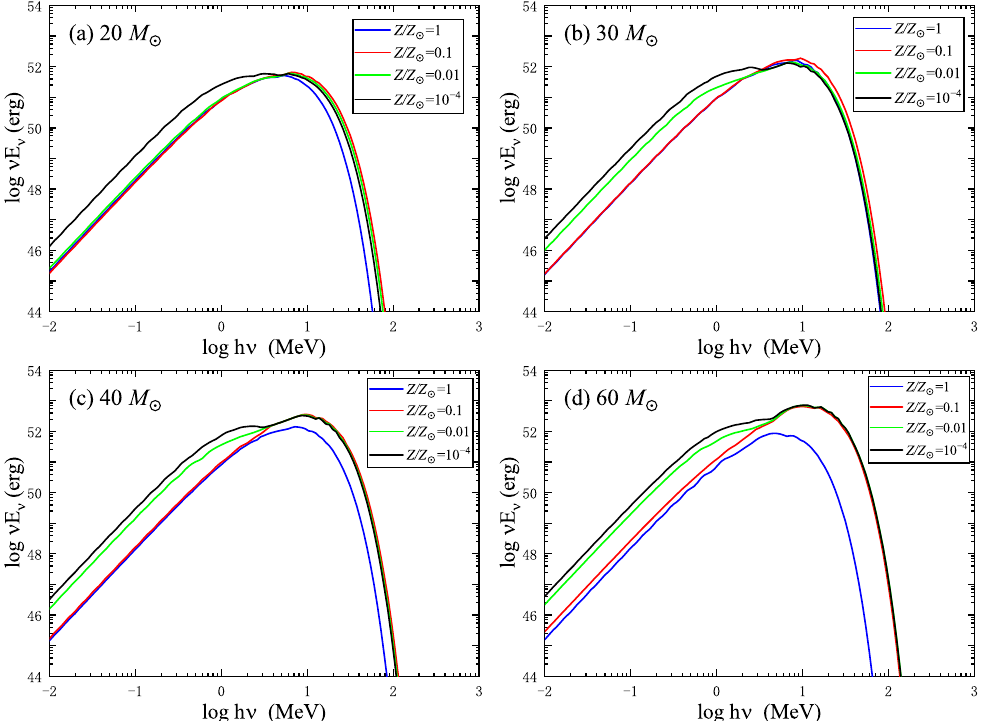
Figure 4. Electron neutrino spectra of NDAFs with different masses and metallicities. Panels ( a – d ) correspond to progenitor star masses of M pro / M (cid:12) = 20, 30, 40, and 60, respectively. The blue, red, green, and black curves correspond to progenitor star metallicities of Z / Z (cid:12) = 1, 0.1, 0.01, and 10 − 4 , respectively. (adapted with permission from Ref.